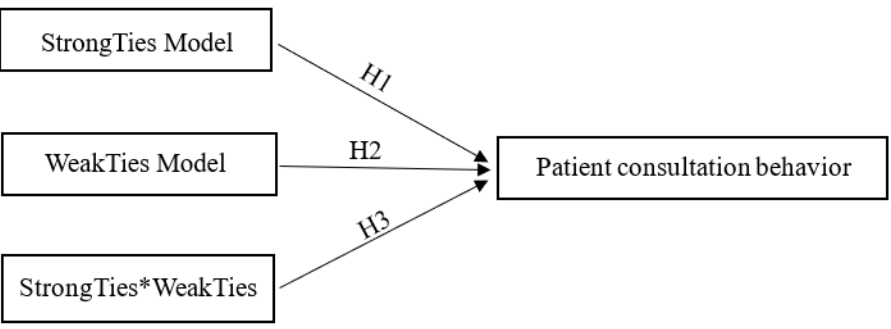
Figure 1. Hypothetical model of influencing factors of patients ’ consultation